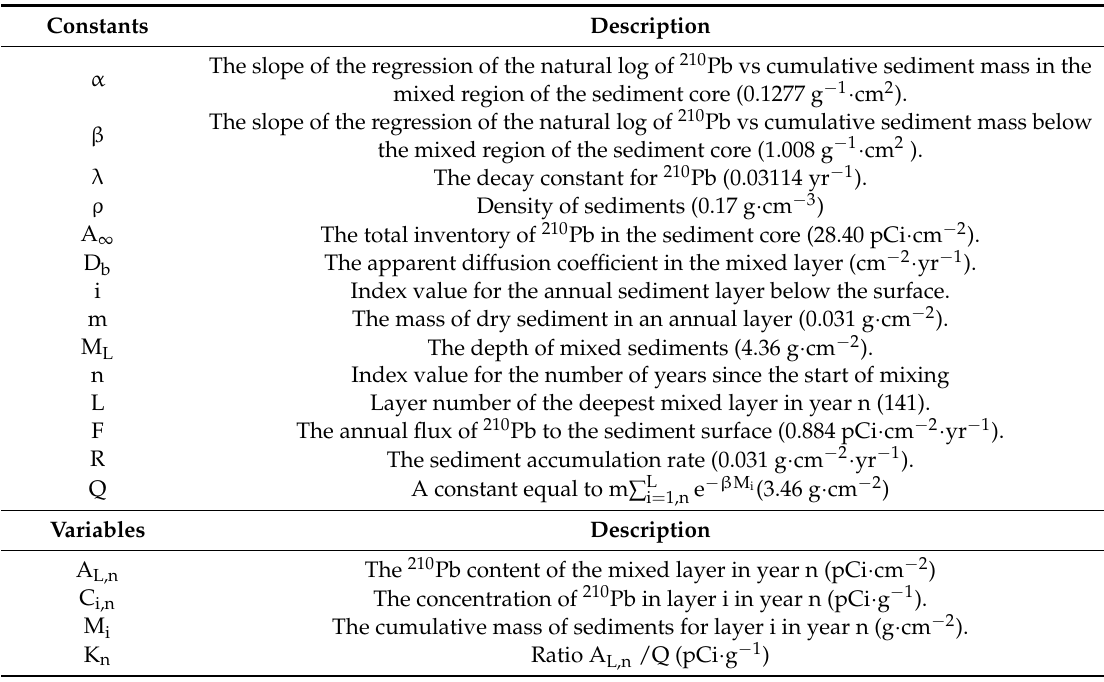
Table 1. List of symbols and values of constants used for Lake West Okoboji model of sediment mixing. In this table 210 Pb refers to unsupported 210